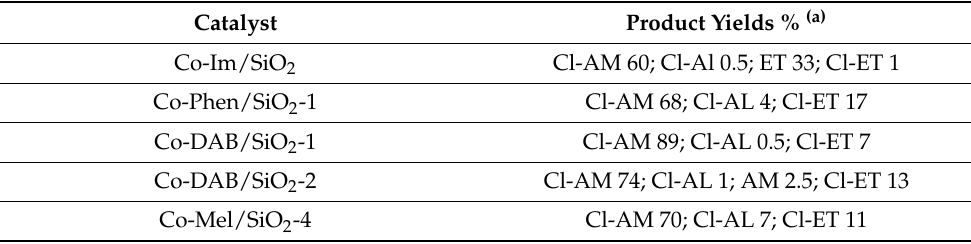
Table 3. The yields of the products in reactions of amination of p -chlorobenzaldehyde with n -butylamine by H 2 in presence of Co-containing composites. Reaction conditions: p(H 2 ) = 100 bar, T =100 °C, catalyst loading 3 mol% (per Co), methanol, time 4 h, 1.5 mmole of n -butylamine per 1 mmol of p -chlorobenzaldehyde.